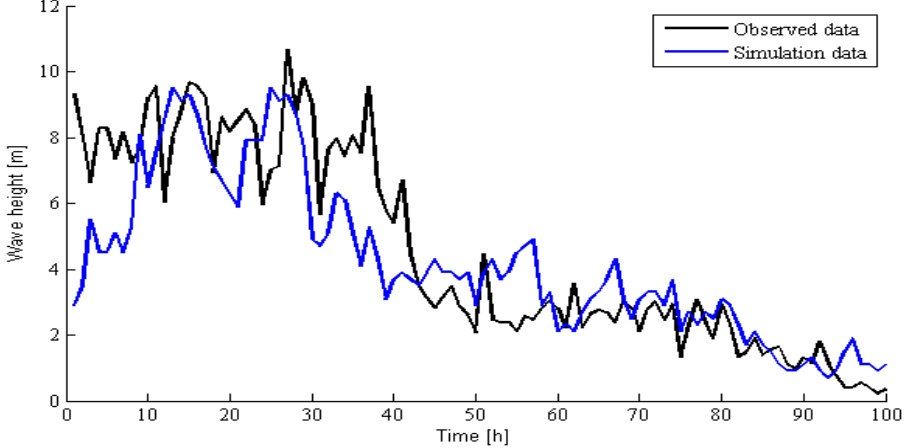
Figure 9. The comparison of predicted and observed values of wave height, wave height prediction curve with ∆ H s = 0.2 m.